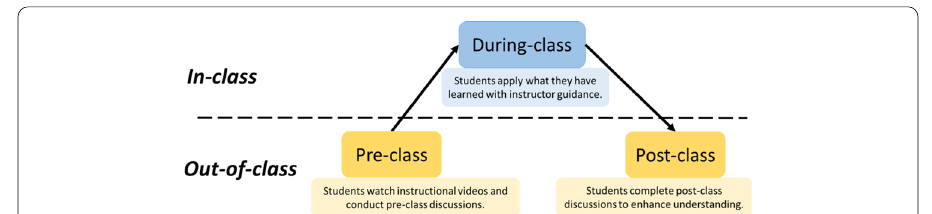
Fig. 3 The learning activities and process of a flipped learning approach adopted in this study